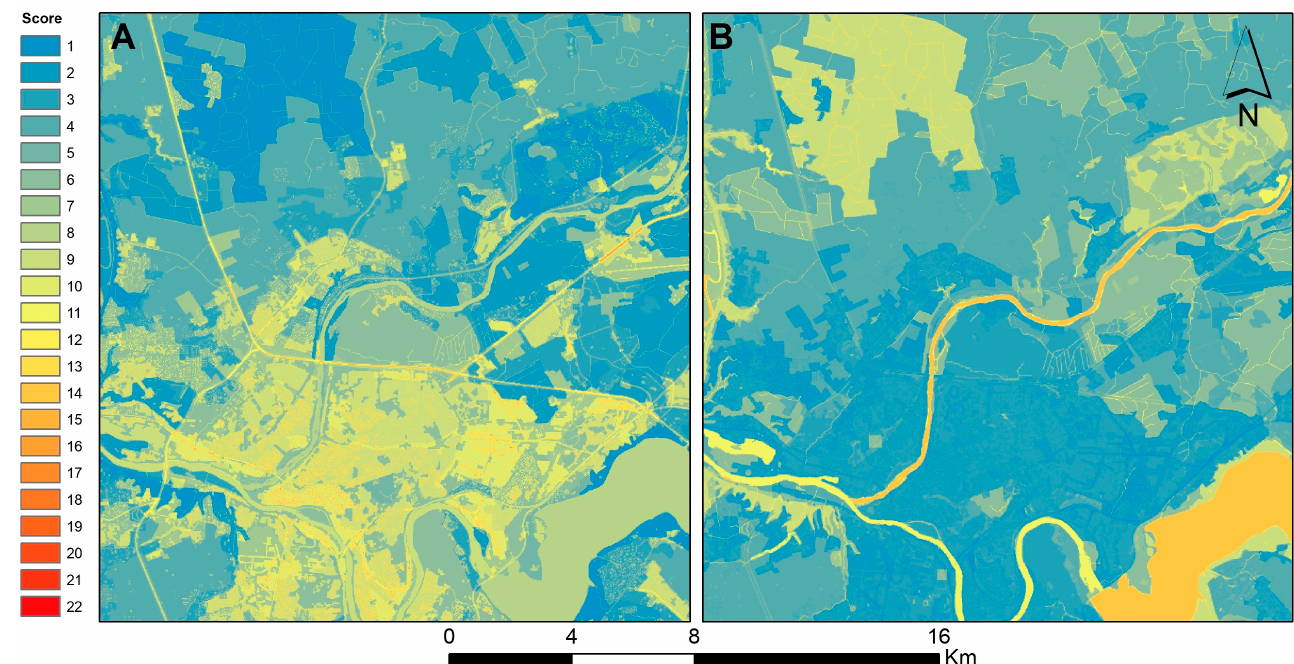
Figure 2. Example of wildlife ( A ) and urban ( B ) resistance grids (a higher total score indicates higher resistance) in the northern agglomeration of the Kaunas city.